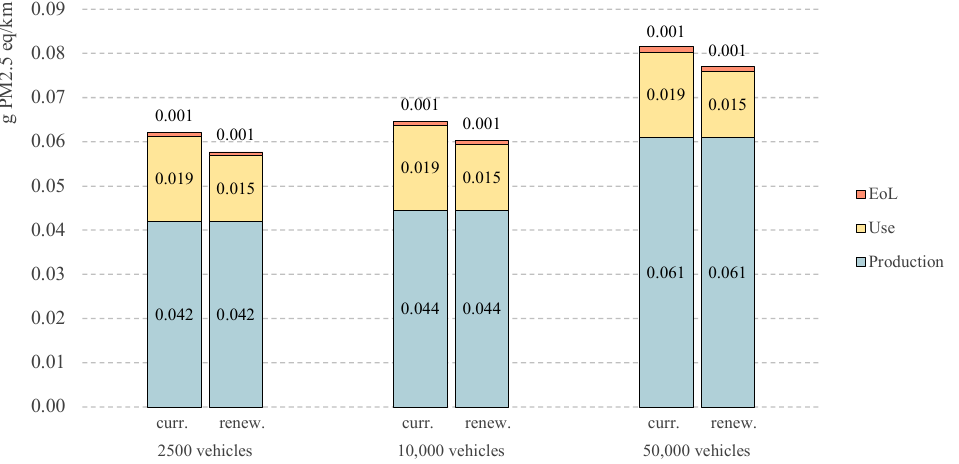
Figure 11. Lifetime particulate matter formation potential of e-moped fleets per kilometer; curr.— current German electricity mix of 2019, renew.—power grid mix resembling 100% renewable